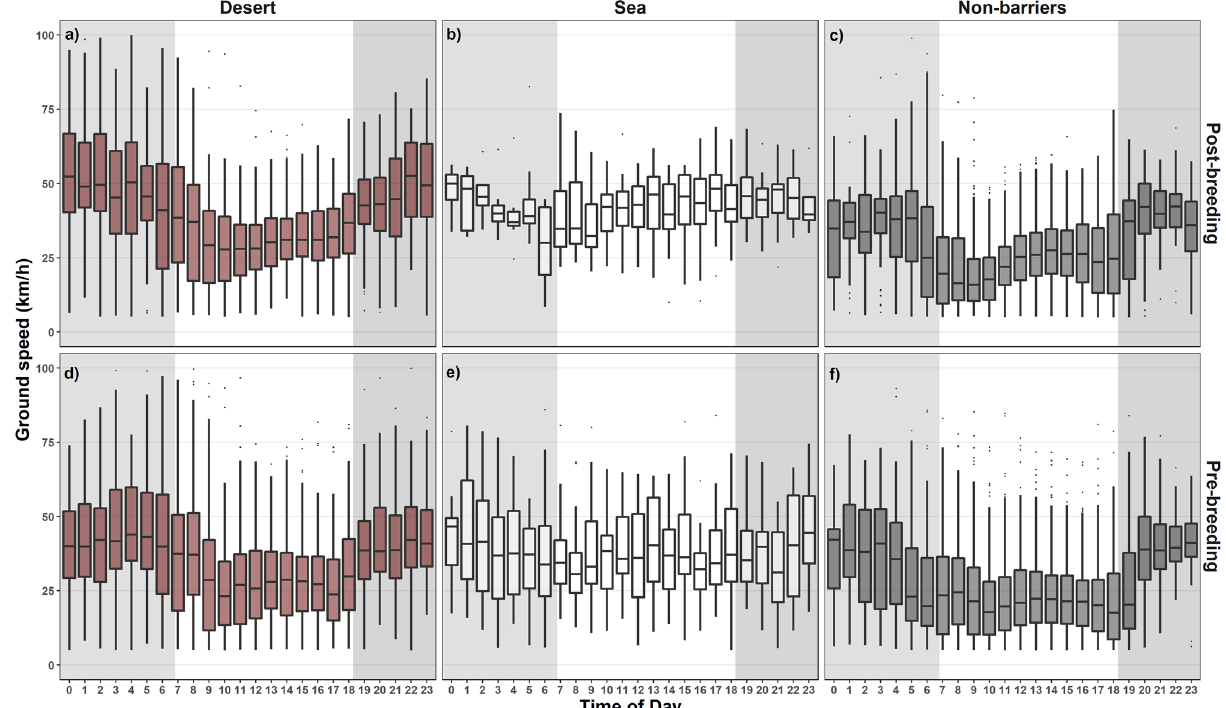
Figure 3. Ground speed during the post-breeding migration over barriers ( a ) desert and ( b ) sea, and ( c ) non- barriers and during the pre-breeding migration over barriers ( d ) desert, ( e ) sea, and ( f ) non-barriers. Only travel segments for each hour of the day are included. The grey areas in the background indicate nocturnal hours, and the white area indicates diurnal hours. Points represent outliers. Speed patterns are more similar when flying over the desert and non-barriers than over the sea, although over the desert, speeds are higher during the post-breeding migration, likely due to supportive winds (see Fig. 4). Over the sea kestrels achieve more constant travel speeds between ~ 25 and 50 km/h with no differences between diurnal and nocturnal flights. During diurnal travel over non-barriers travel speed typically falls below 25 km/h.